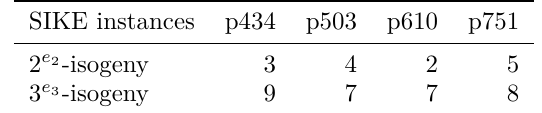
Table 3: Break-point exponents o for all parameter